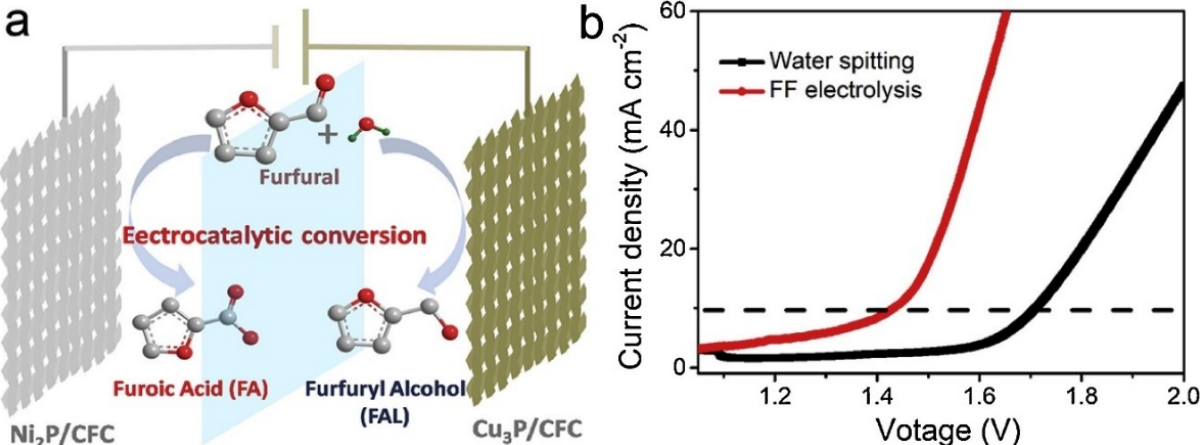
Figure 4. ( a ) Schematic diagram of Cu 3 P/CFC and Ni 2 P/CFC for two-electrode electrocatalytic con- version of furfural. ( b ) LSV plots without iR compensation of Cu 3 P/CFC (as cathode) and Ni 2 P/CFC (as anode) two-electrode system in 1.0 M KOH without and with 50 mM furfural. Reprinted with permission from Ref [99]. Copyright 2019 Elsevier Inc.